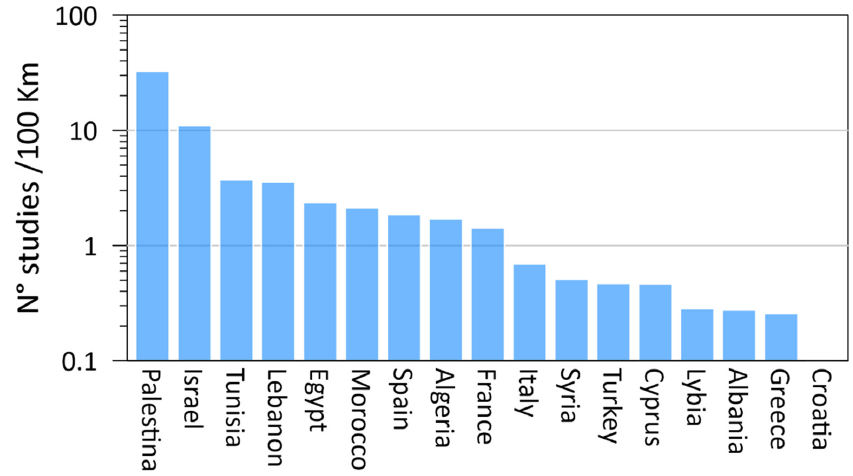
Figure 3. Number of studies focusing on GW salinization with respect to the coastal extension of each country along the Mediterranean.